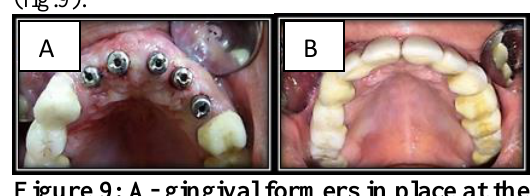
Figure 9: A- gingival formers in place at the top of implants during second stage surgery. B- Final